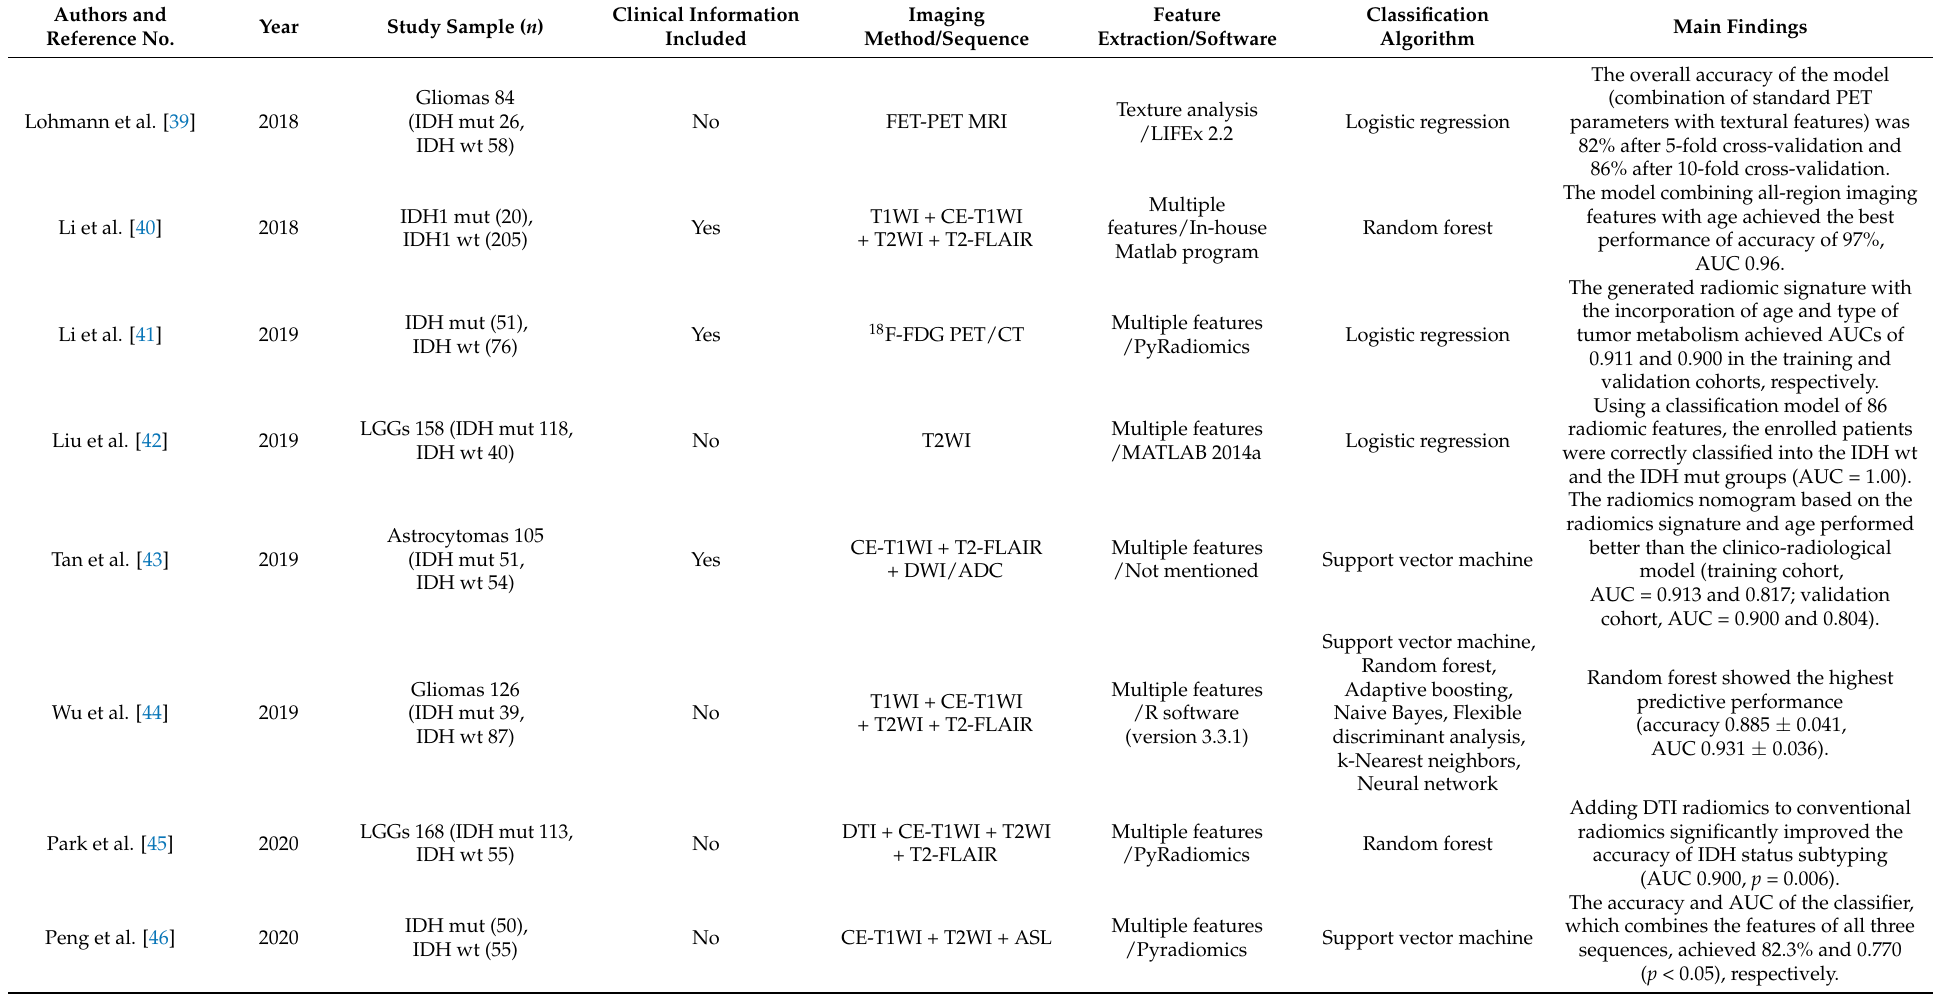
Table 3. Studies Investigating the Role of Radiomics in Predicting IDH Mutation